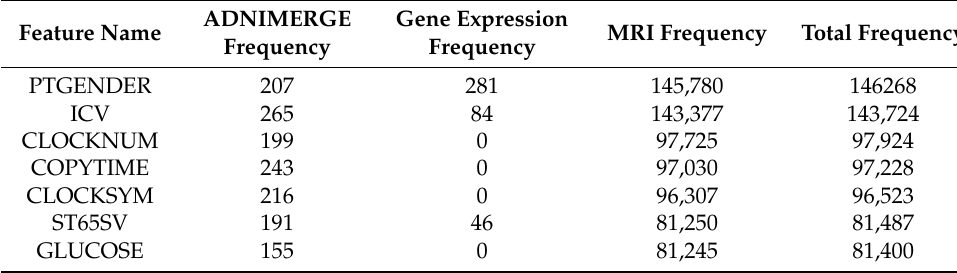
Table 2. ADNIMERGE Features that are Highly Correlated with other Features.